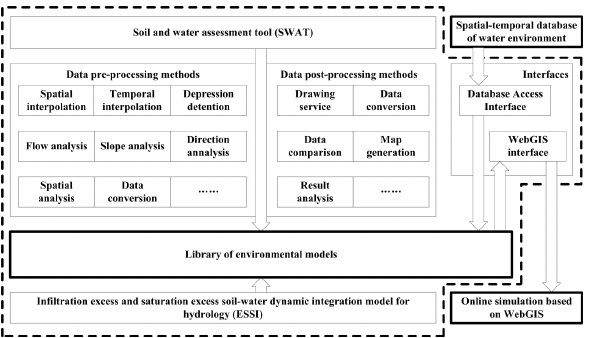
Figure 3. The technical route to establish the library of environmental